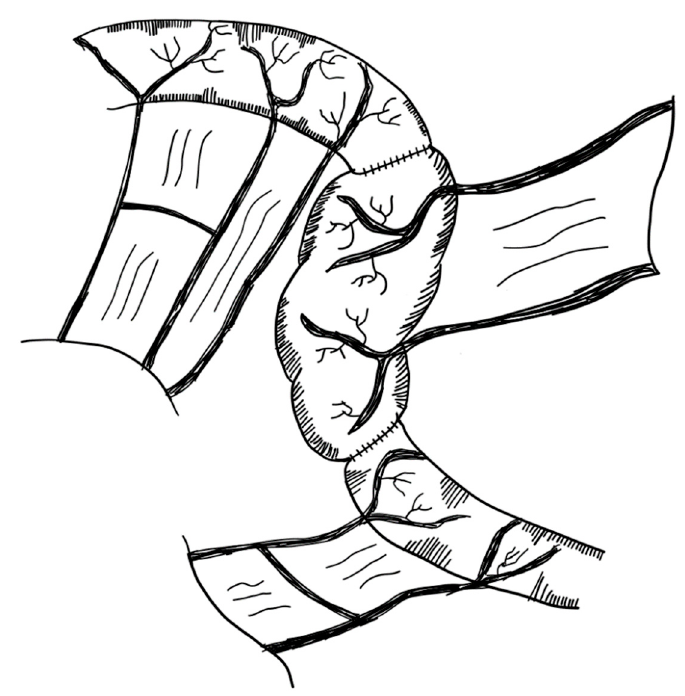
Figure 12. Interposition of a colon segment in the small intestine. Lloyd [160].